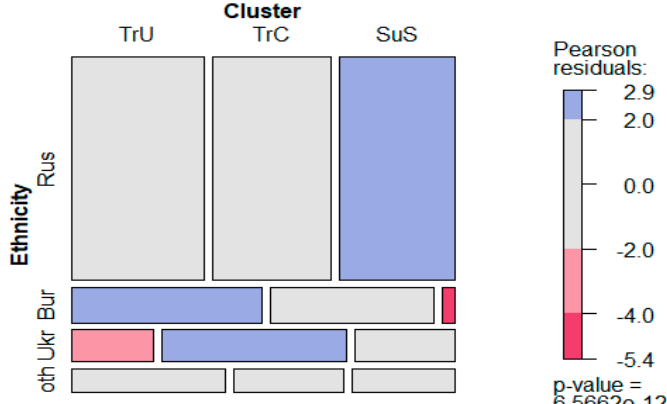
Figure 4. Occurrence of value clusters in different ethnic groups. Cluster abbreviations: TrU—Traditionalist–Universalist